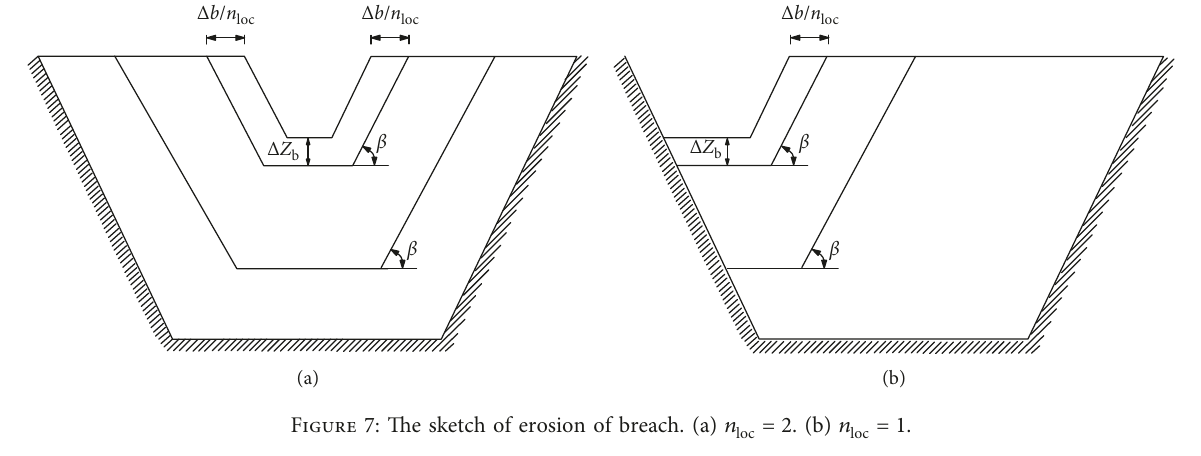
Figure 7: The sketch of erosion of breach. (a) n